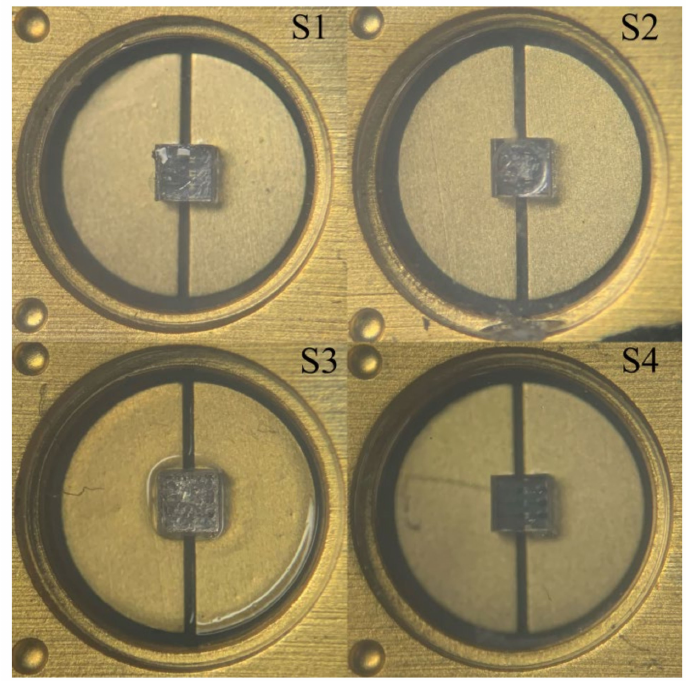
Figure 4. Photographs of samples S1–S4 taken after 3500 h of